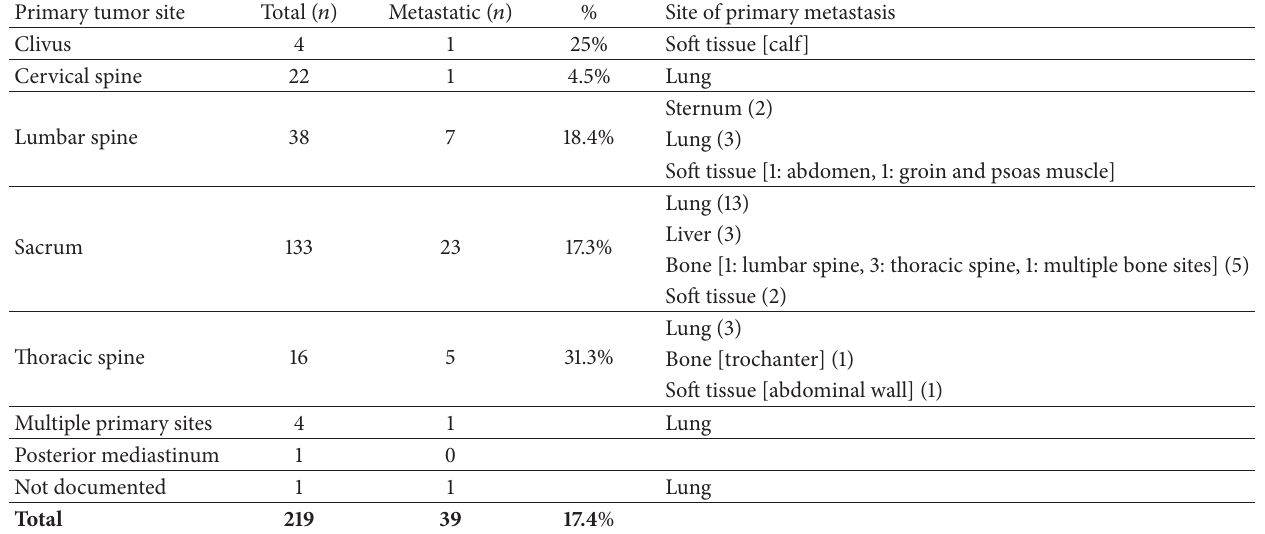
Table 4: Patterns of primary metastasis.